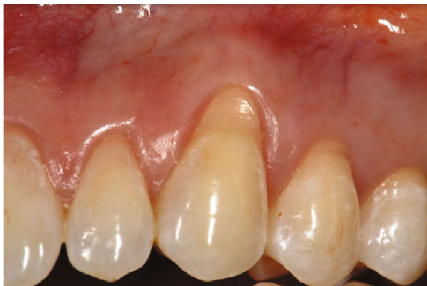
Figure 2: Miller Class I gingival recession on the maxillary left canine (recipient site).